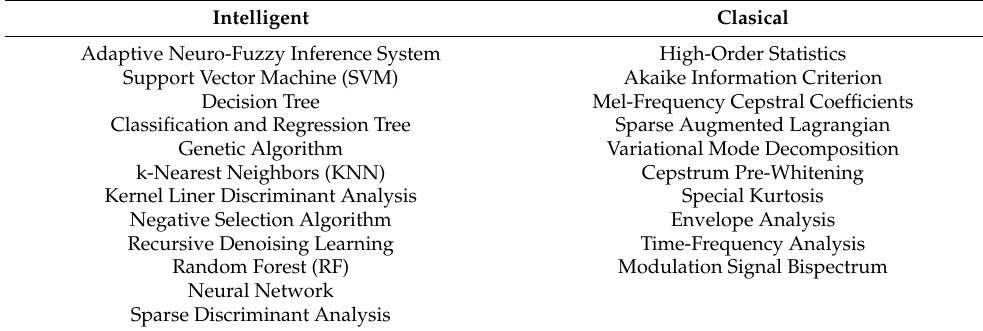
Table 9. Algorithm or analysis method used to define failure.